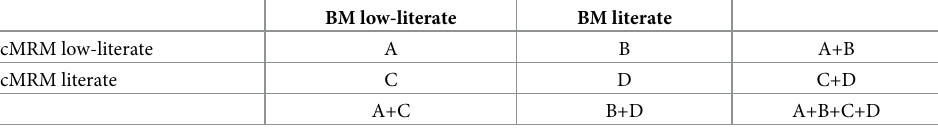
Table 1. Contingency table for agreement between the bookmark procedure (BM) and constrained Mixture Rasch Model (cMRM).